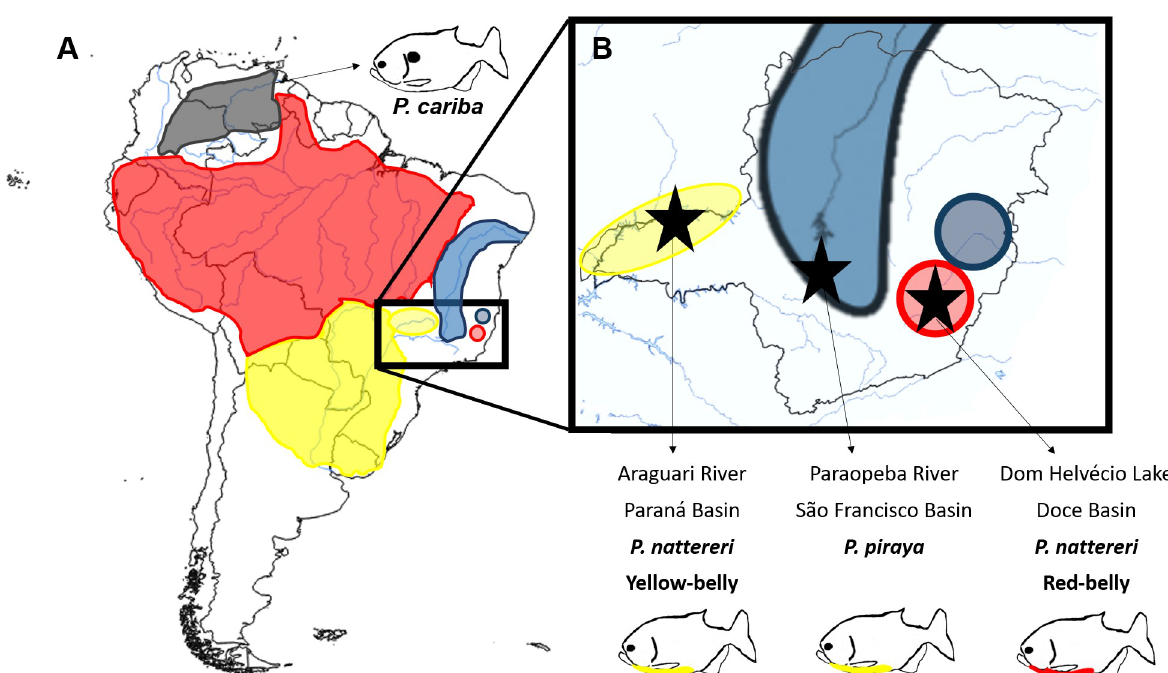
Fig 1. A. Distribution of the different species of genus Pygocentrus modified from [48] and adapted with data from non-native populations [39– 41,49]. The range of P . cariba is represented in black, that of P . nattereri is approximately divided into red and yellow according to the colouration of the belly and the river basins, and that of P . piraya is in blue. B. Locations of sampling sites (black stars) in Minas Gerais state, Brazil.